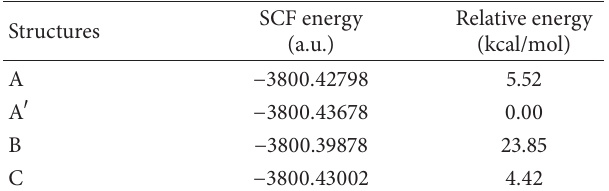
Table 2: Relative energies of structures A–C determined by ab initio